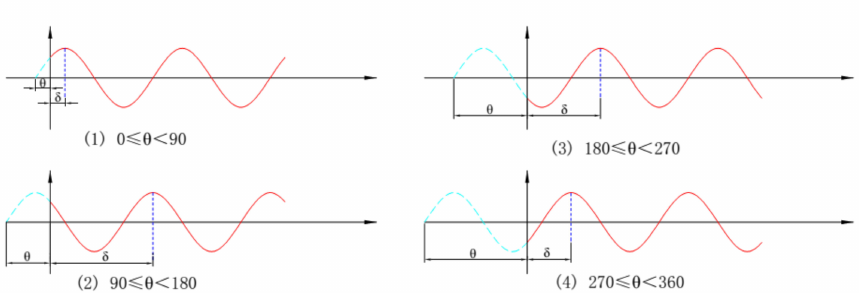
Figure 8. Relationship between the initial phase and peak phase.